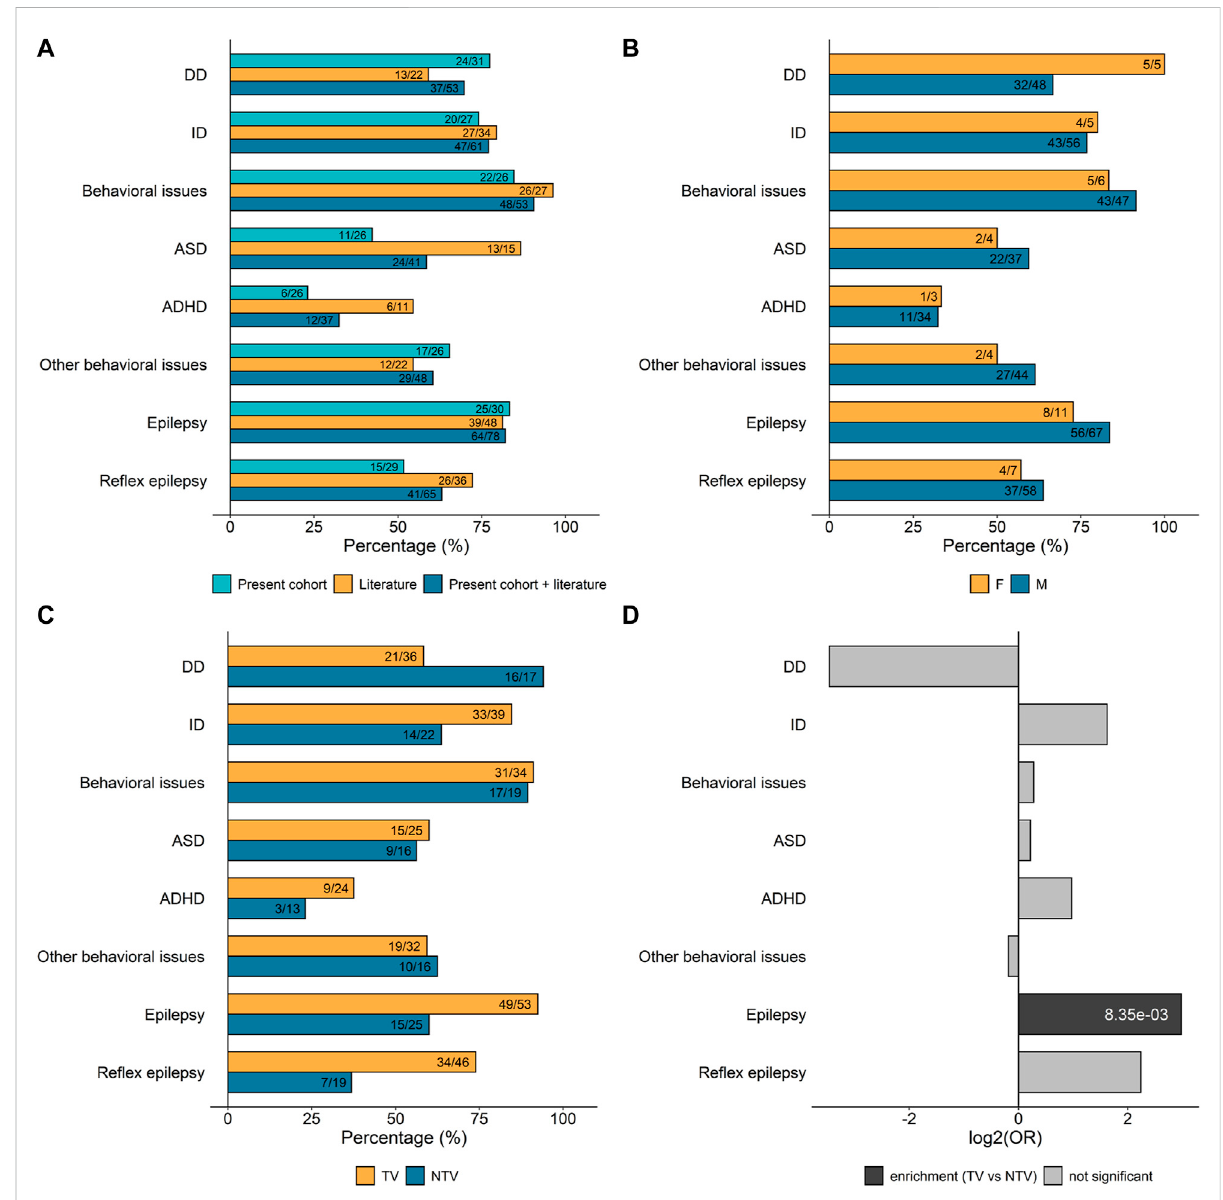
FIGURE 4 Frequency of the main clinical features associated with SYN1 variants. Numbers inside the bars are ratios between the number of patients presenting with the speci fi c clinical sign and the number of patients for which information on that speci fi c feature was available. (A) Percentage of SYN1 patients in our cohort and/or in the literature manifesting the clinical features of interest. (B) Percentage of male and female SYN1 patients manifesting speci fi c clinical features. Data from patients in our cohort and the literature were combined. (C) Percentage of patients with either truncating variants (TV) or non-truncating variants (NTV) manifesting speci fi c clinical features. Data from patients in our cohort and the literature were combined. TV: nonsense, frameshift and splicing variants; NTV: missense substitutions and in-frame duplications. (D) Per clinical feature enrichment/depletion of TV versus NTV. Only signi fi cant p -values are shown inside bars (Fisher ’ s test followed by Bonferroni correction for multiple testing; Supplementary Table S4). DD, developmental delay; ID, intellectual disability; ASD, autism spectrum disorder; ADHD, attention de fi cit hyperactivity